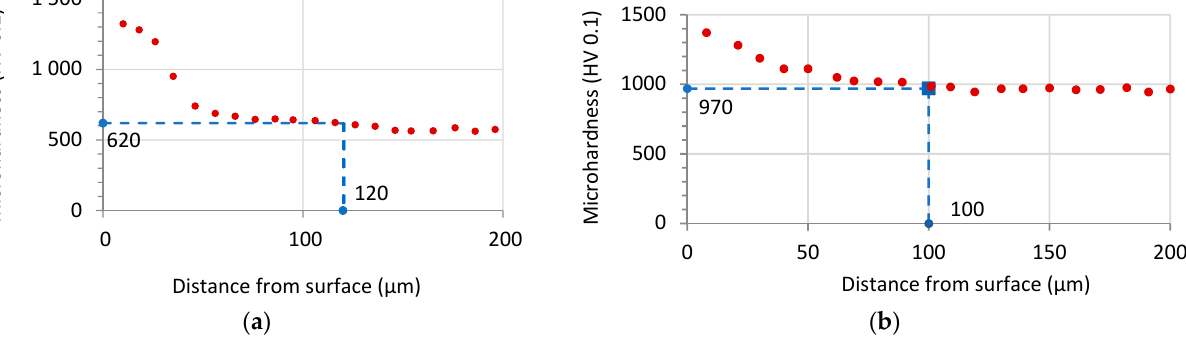
Figure 6. Microhardness profiles of the nitrided samples: ( a ) steel H13; ( b ) steel HS6-5-2.